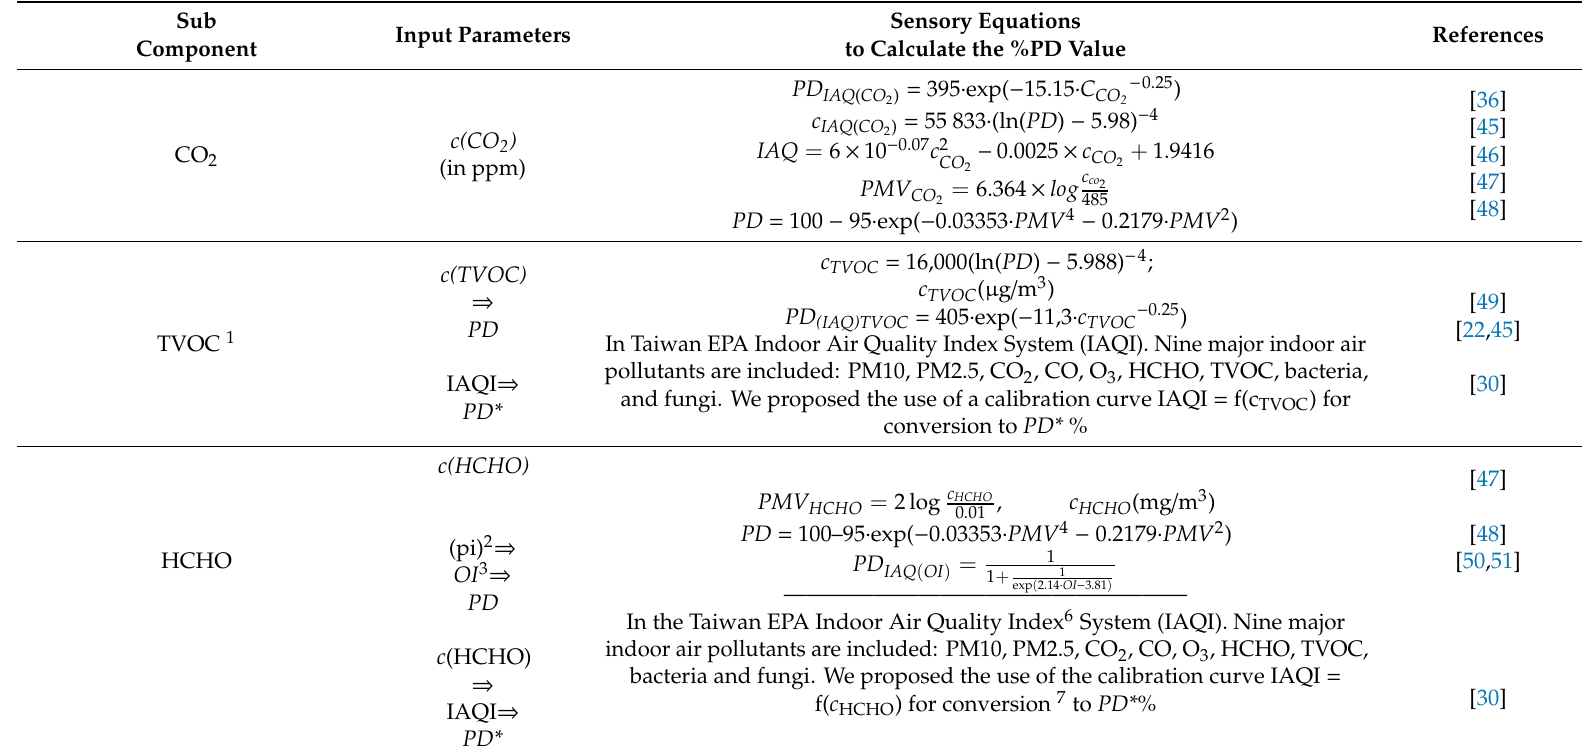
Table 3. Selection of physical equations for IAQ index components and dependences for PD = f( c j